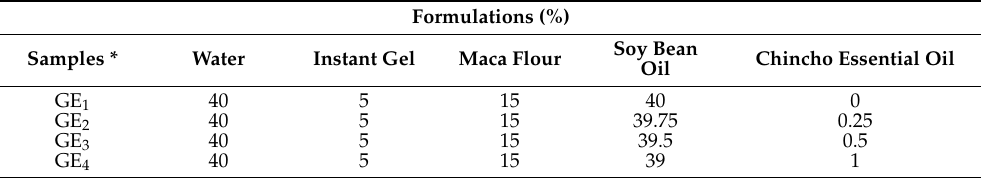
Table 1. Composition of maca-soybean oil and chincho essential oil gelled emulsions (GE). Formulations (%)